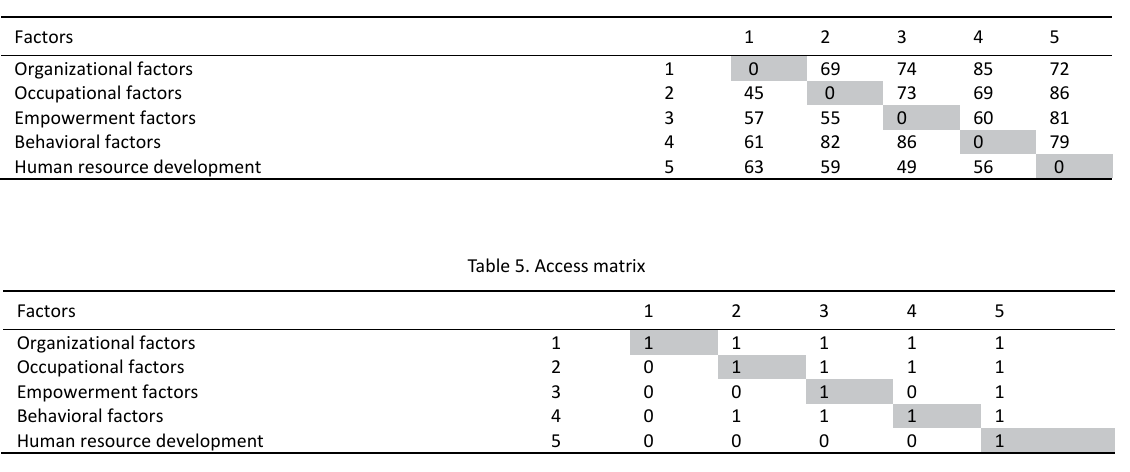
Fig. 2. The variables of the HRD model in SOE Table 4. The SSIM matrix